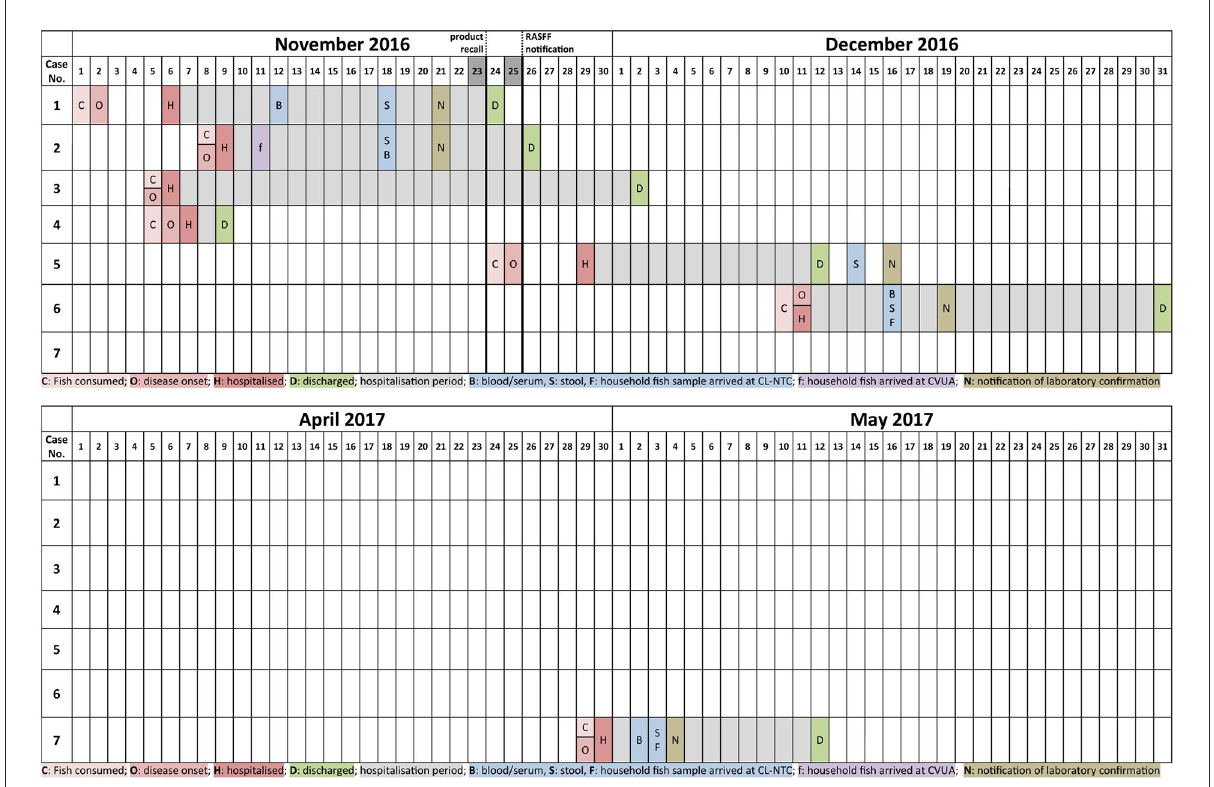
FIGURE1 Timeline of outbreak events including information on the dates of fish consumption (C), disease onset (O), hospitalization (H), and discharge from hospital (D) as well as the dates were samples of blood/serum (B), stool (S), leftovers of household fish arrived at the CL-NTC (F) or CVUA (f). Furthermore, the date of mandatory notification of the laboratory results to the local health authorities (N) is indicated.